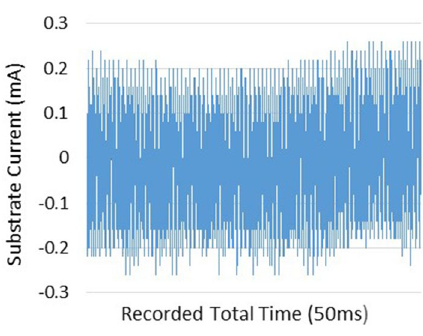
Figure 17. Substrate current, while the TRC2 plasma jet collides the target.